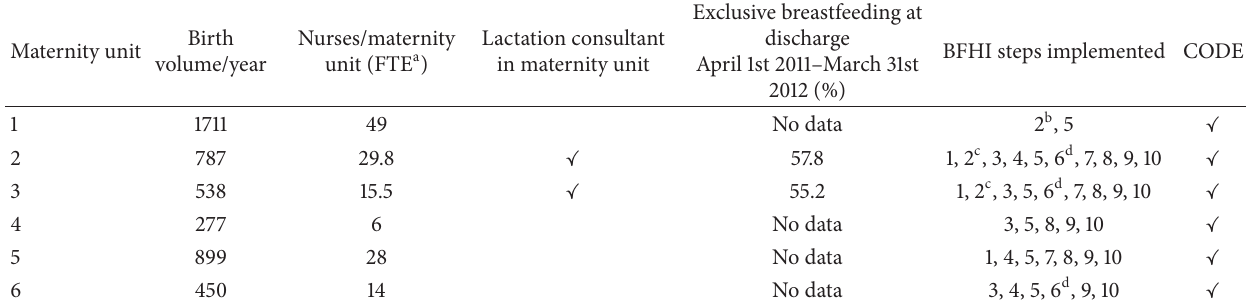
Table 3: Maternity units demographics and BFHI status.